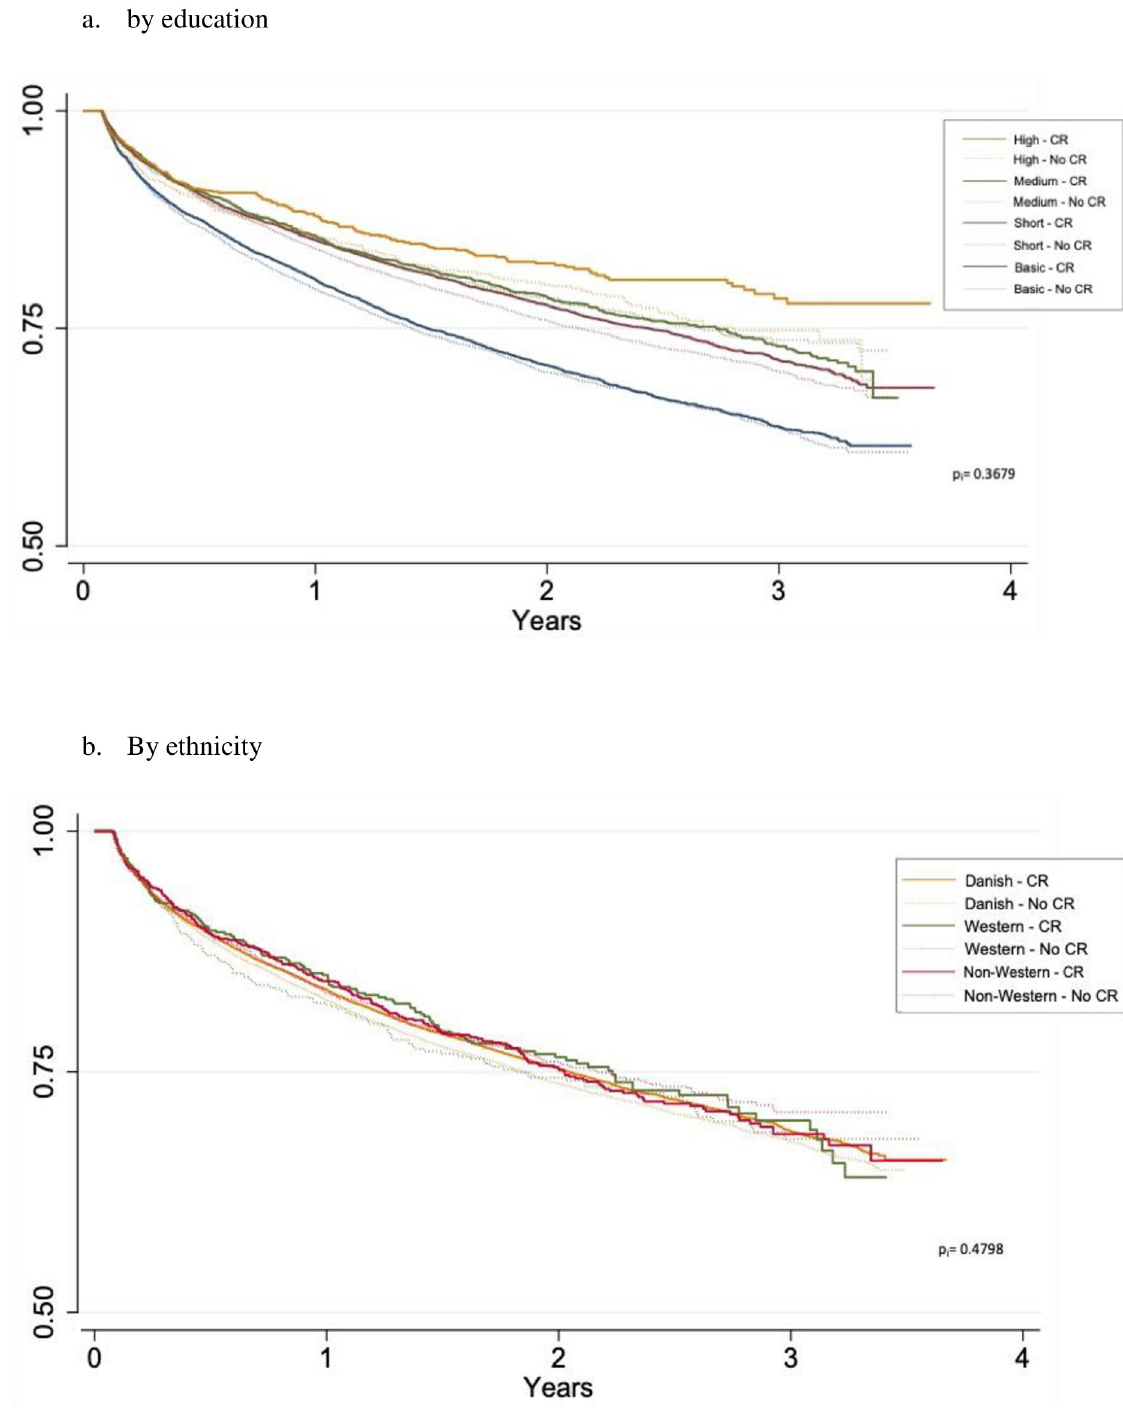
Fig 2. Risk of MACE by CR participation across education and ethnicity among 34.511 patients in the DNPR population presented by Kaplan-Meier plots. a. by education and b. By ethnicity. p i = p for interaction, abbreviations: CR: Cardiac rehabilitation.